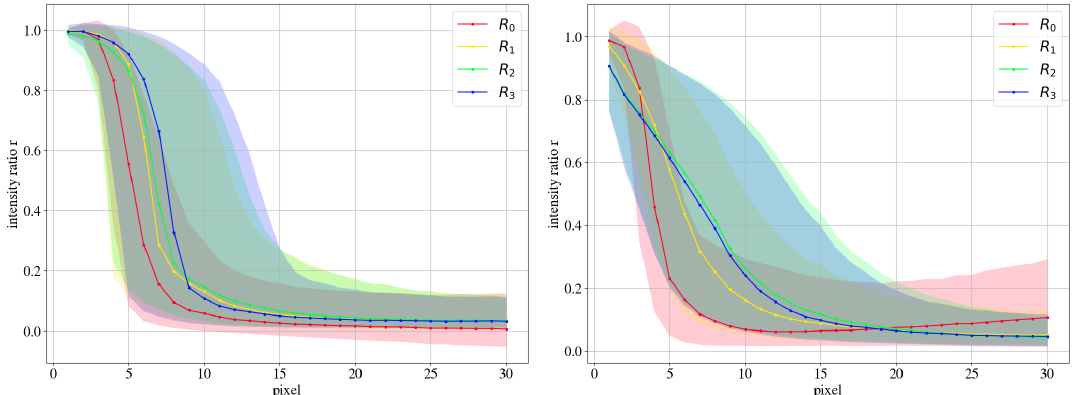
Figure 9 . Median and bands for the 25%/75% quantiles for the distribution of r for the leading pixels, where r is the ratio of the reconstructed and the input intensity of a given pixel in a given jet. Results are shown for QCD jets (left) and top jets (right). The AE is trained on the respective training set with a given